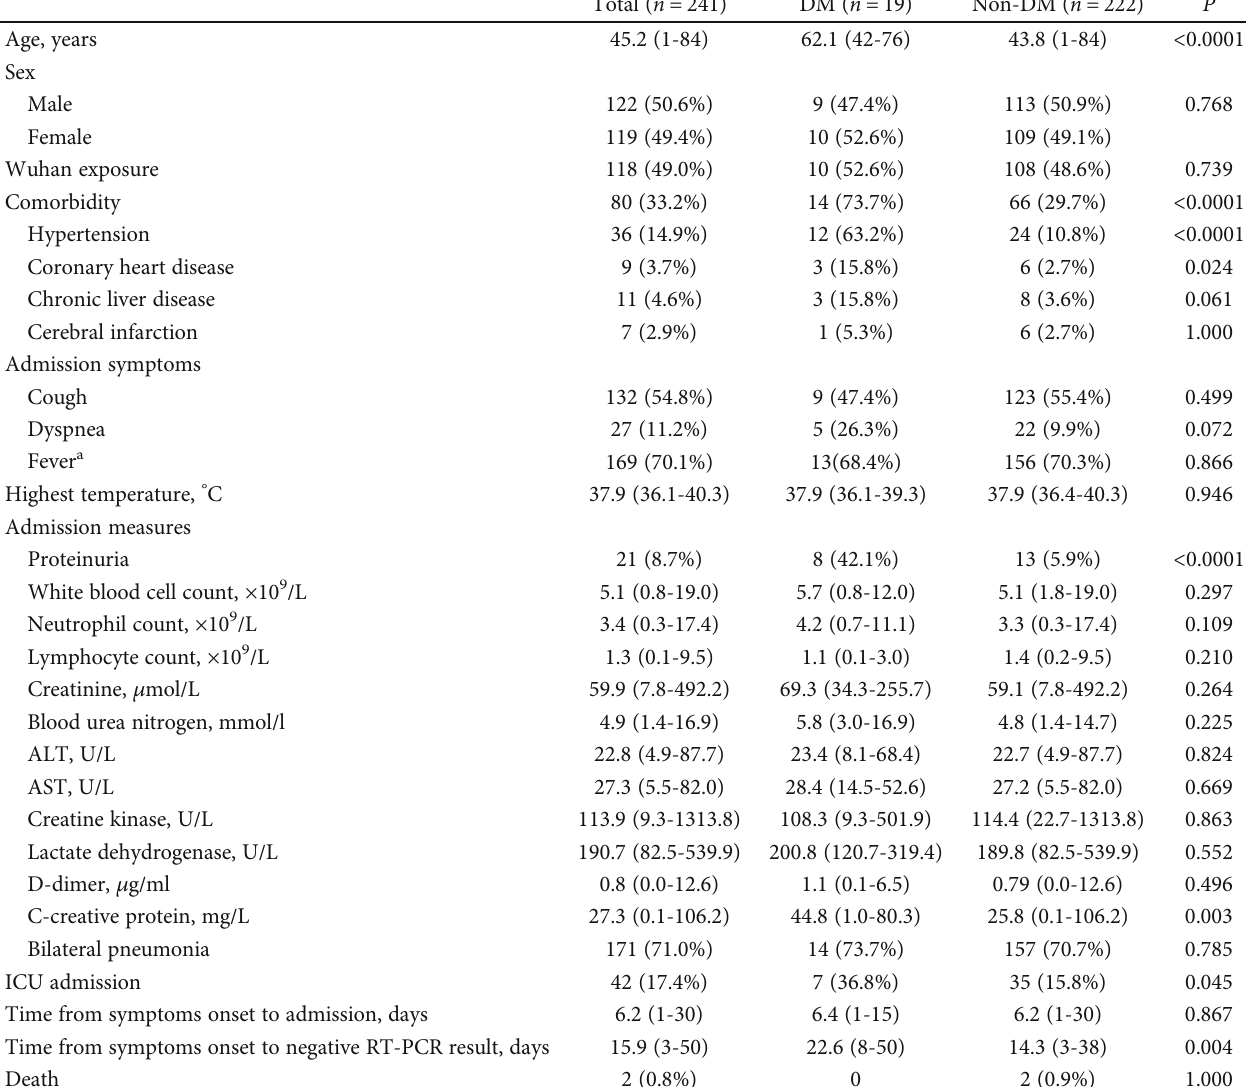
Table 1: Comparisons between COVID-19 patients with DM and without